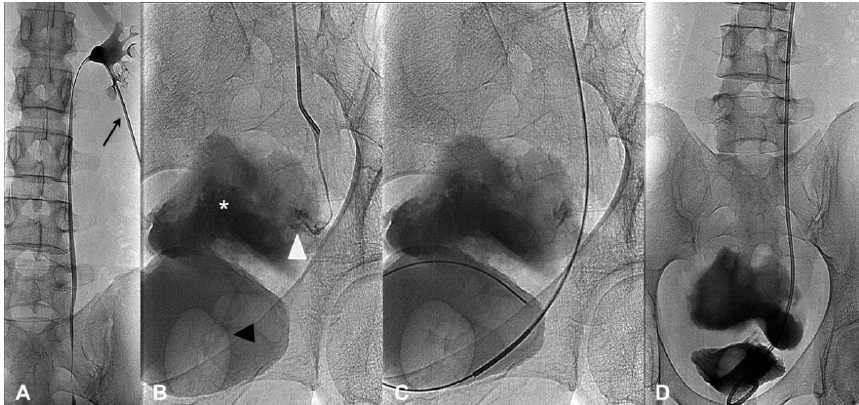
Figure 1. ( A – D )—A successful anterograde approach. Right descending pyelography ( A , B ) performed using a 5 Fr introducer (black arrow) proves a lesion (white arrow head) of the distal third of the right ureter associated with urinoma (white asterisk); the bladder is distended by contrast medium injected through a urinary catheter (black arrow head). ( C ) A hydrophilic guidewire is advanced in the bladder with a catheter through the ureteral distal stump and a double-J stent ( D ) was implanted and correctly positioned.